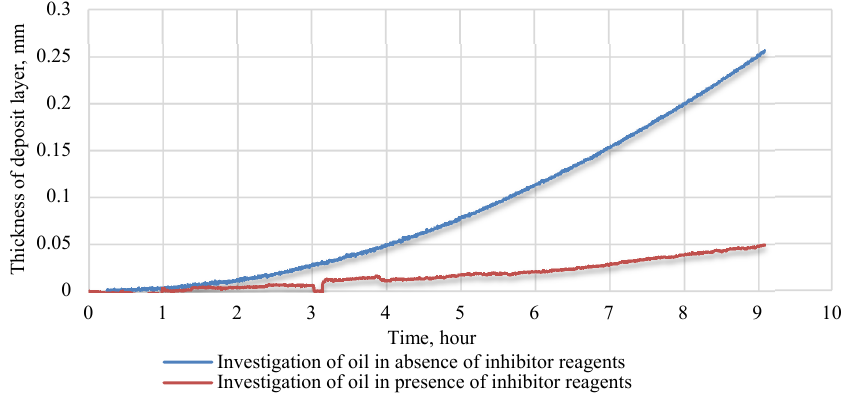
Figure 5. Dependences of the thickness of wax deposits on time.